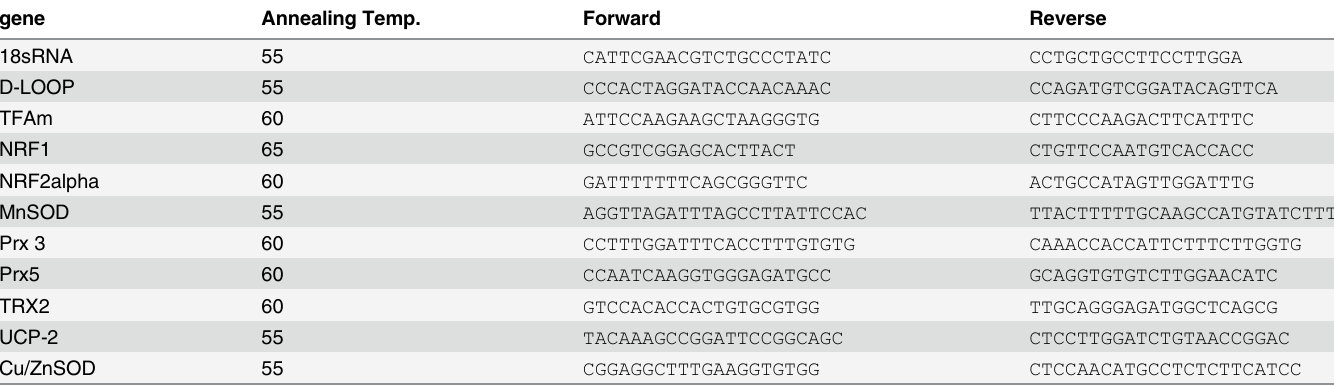
Table 1. Primers and annealing temperature. gene Annealing